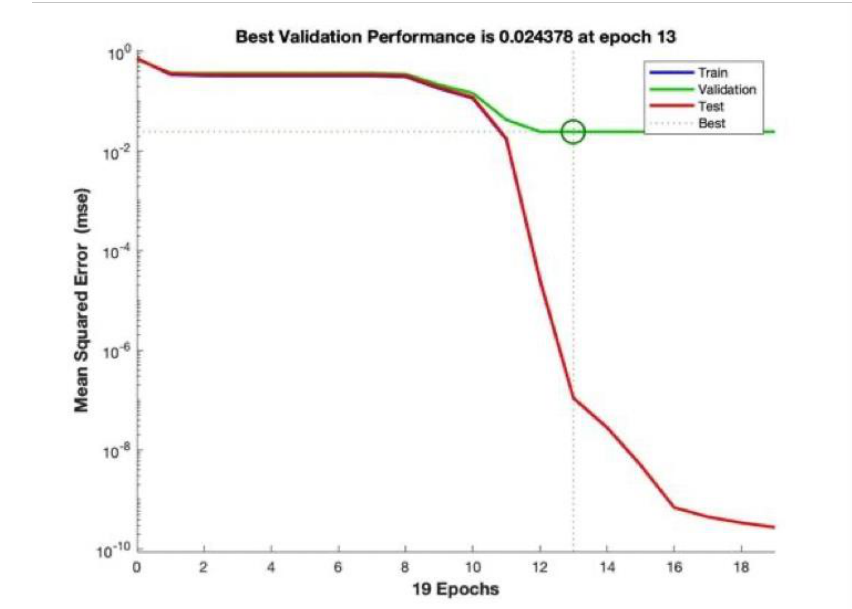
Classification Performance of SubA_5chan_3LRF by RNN